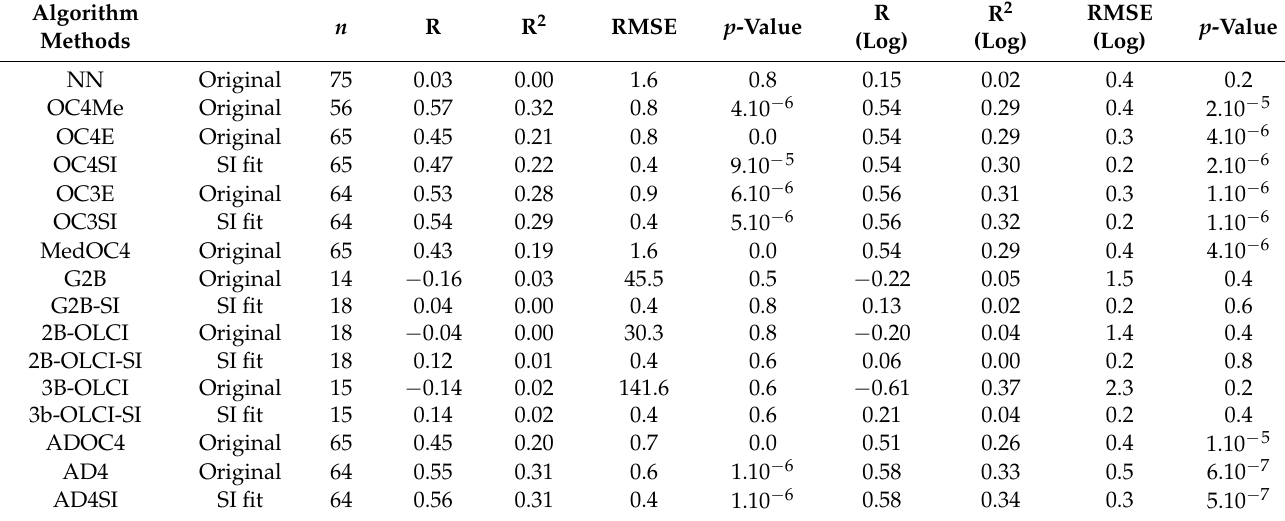
Table 4. Statistical analysis (R, R 2 , RMSE and p-value) for the original (OC4Me, NN, OC3E, OC4E, MedOC4, ADOC4, AD4, 3B-OLCI, 2B-OLCI and G2B) and recalibrated (OC4SI, OC3SI, AD4SI, G2B-SI, 2b-OLCI-SI, 3B-OLCI-S) Chl- a algorithms on same-day